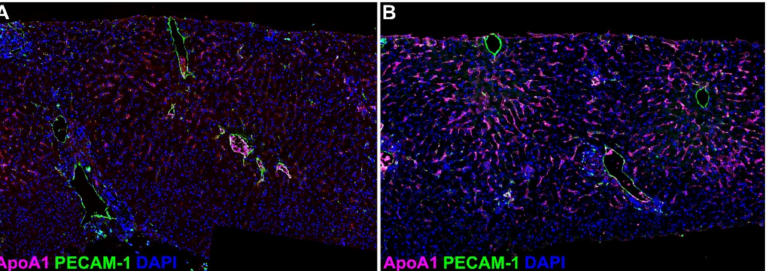
Figure 4. Detection of apolipoprotein A1 (pink, ApoA1) and platelet–endothelial cell adhesion molecule 1 (green, PECAM-1) by double immunofluorescence staining in postreperfusion liver biopsies. ApoA1 expression ranged from low ( A ) to high ( B ) and showed sinusoidal staining pattern; PECAM-1 expression was found on larger vessels (centrolobular and portal veins, arterioles). Nuclei were counterstained with DAPI (blue). Original magnification × 200.